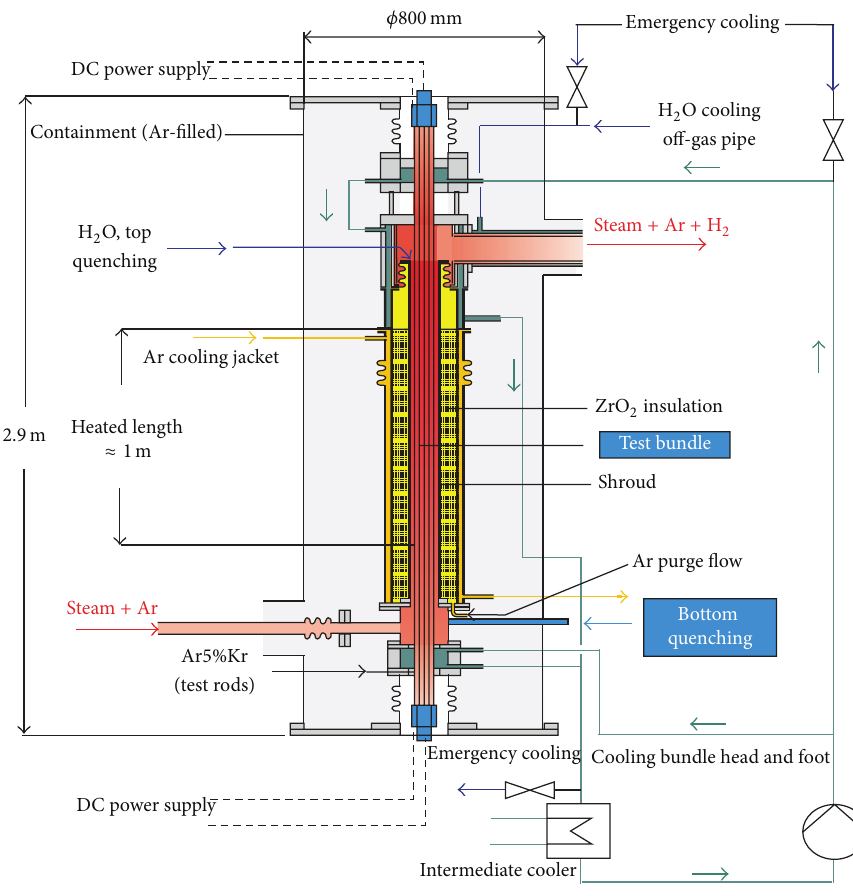
Figure 1: Test section of the QUENCH bundle